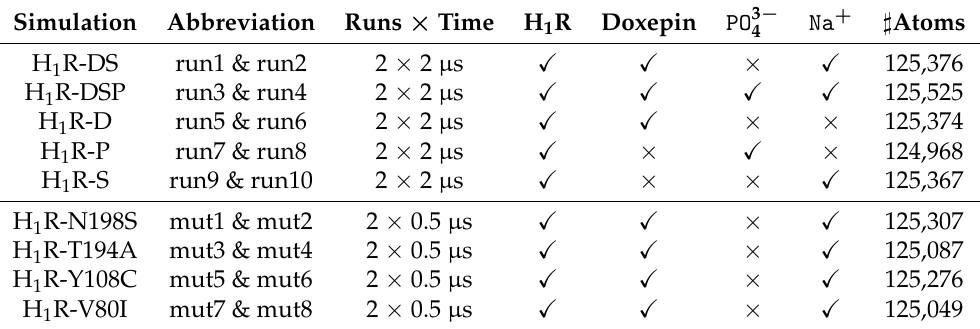
Table 3. Overview of the simulations performed. The table lists all MD simulations conducted and the respective names by which they are referred to in the figures and manuscript text. Further, the number of runs and the time simulated are given. The following columns describe the composition of the respective systems, i.e., whether the histamine H 1 receptor (H 1 R), the ligand doxepin, the phosphate ion ( PO 3 − ), or the sodium ion ( Na + ) was present. For the simulations of mutant H 1 R, the 4 type of mutation is indicated in the first column. The mutation runs are based on the setup for run1 and therefore bear the same overall molecule counts. The starting conformations are taken from the last 100 ns time frames of run